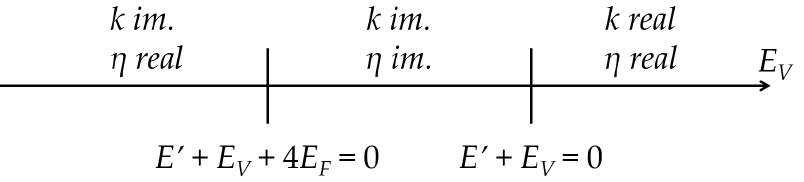
Figure 3. Intervals which determine whether η is real or imaginary When E (cid:48) + E V < 0, k is pure imaginary and (5) is modified as follows: